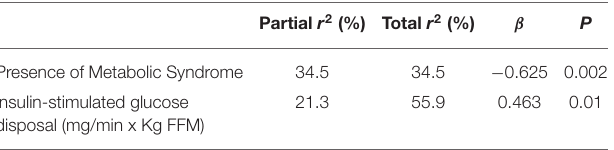
Model including age, gender, BMI, waist circumference, blood pressure, lipid profile, fasting plasma glucose, HbA1c, fasting plasma insulin, insulin-stimulated glucose disposal, diabetes duration, presence of Metabolic